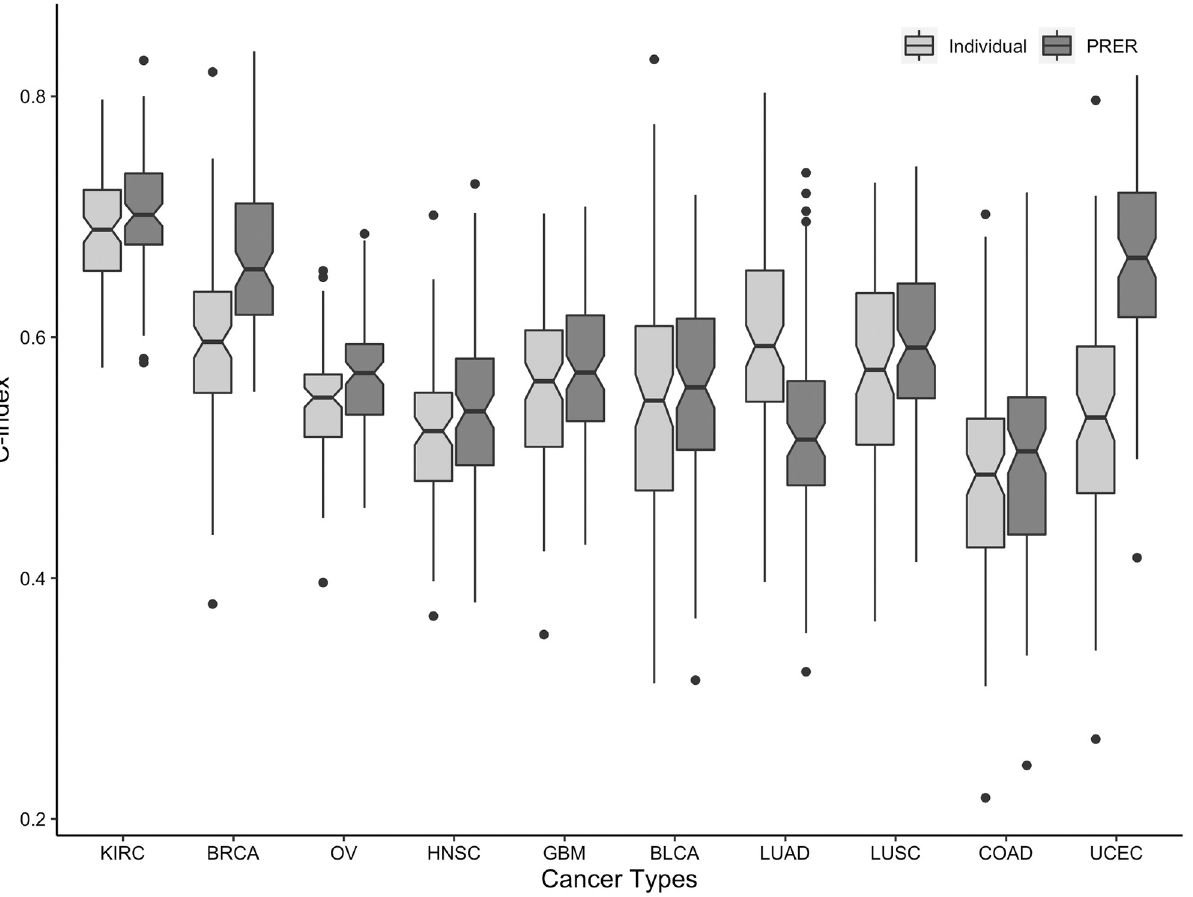
Fig 3. Comparison of RSF model performances that are trained with individual proteins and pairwise ranking representations for different cancer types. The distribution is over 100 models trained that have different random train and test splits. The performances of the models that use the individual expression values as features (Individual) and PRER representation as features (PRER) are compared in each case.